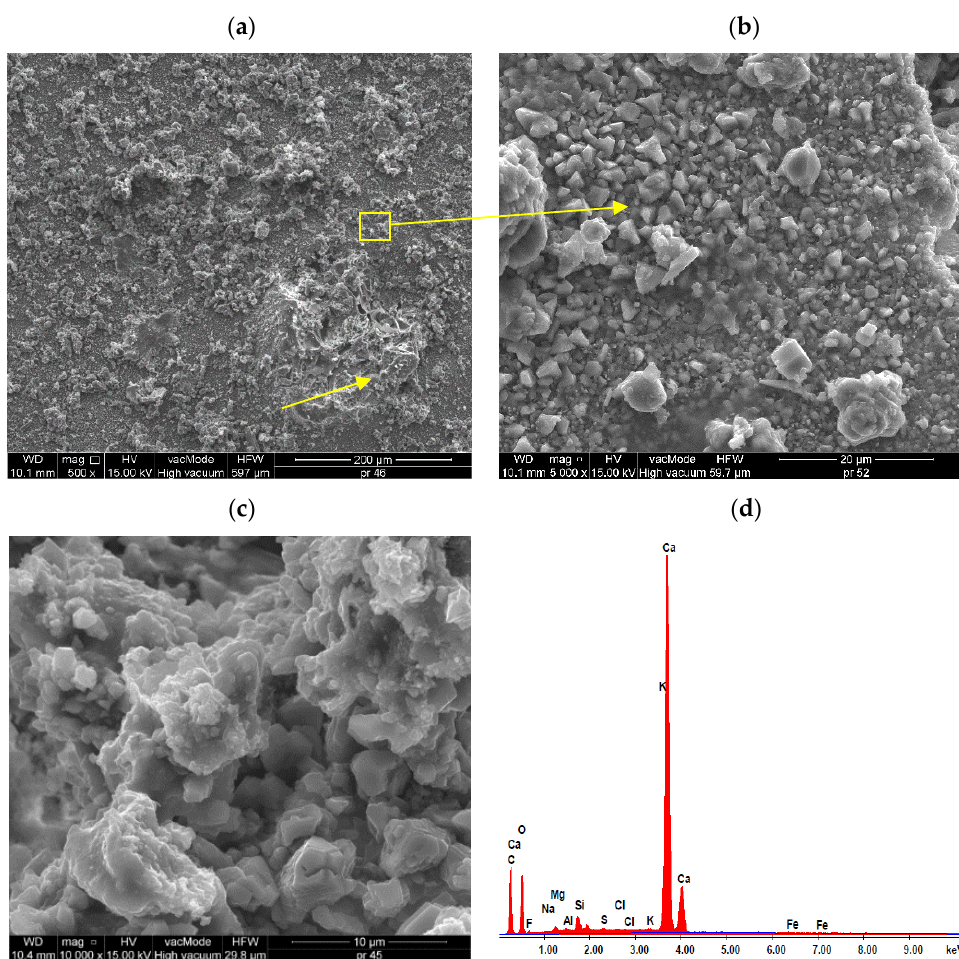
Figure 10. Micro-structure of hydrophobic coatings A2 on the micro-structure of mortar: ( a ) A2.8—a visible thin hydrophobic film which has not completely covered perlite grains ( × 500), ( b ) A2.4—polysiloxane gel particles ( × 5000), ( c ) A2.4—micro-area well-developed C-S-H phase crystals ( × 10 4 ), ( d ) results of elemental analysis in EDS micro-area from the surface of hydrophobized samples.